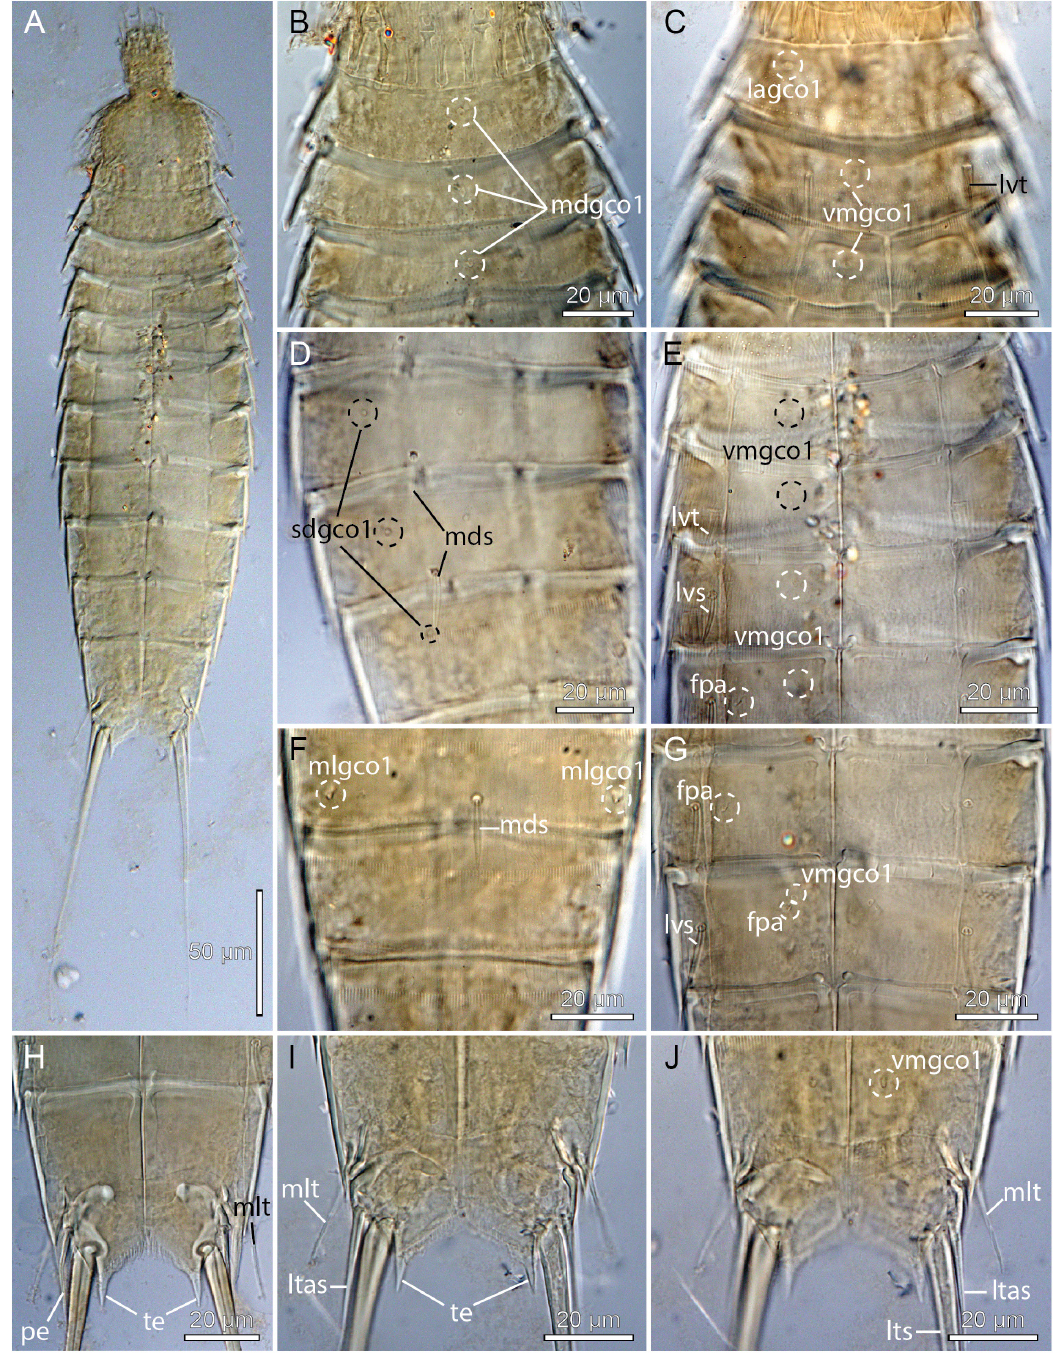
Fig. 20. Light micrographs showing overviews and details of Echinoderes songae Sørensen & Chang sp. nov. A–B, E–G, I–J . Holotype, ♀ (NHMD-662101). C . Paratype, ♀ (NHMD-662102). D . Paratype, ♀ (NHMD-662103). H . Paratype, ♂ (NHMD-662104). A . Ventral overview. B . Segments 1 to 3, dorsal view. C . Segments 1 to 3, ventral view. D . Segments 7 to 9, dorsal view. E . Segments 4 to 7, ventral view, showing female sexual dimorphism. F . Segments 8 to 9, dorsal view. G . Segments 7 to 8, ventral view, showing female sexual dimorphism. H . Segments 10 to 11, ventral view, showing male sexual dimorphism. I . Segments 10 to 11, dorsal view, showing female sexual dimorphism. J . Segments 10 to 11, ventral view, showing female sexual